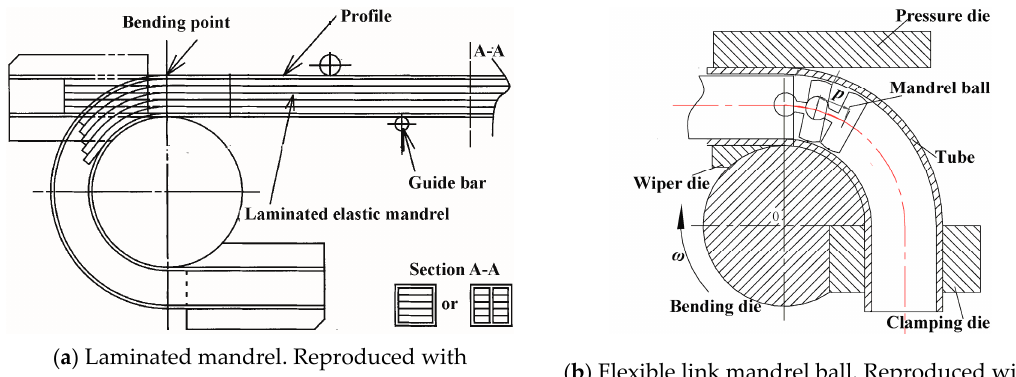
Figure 6. Mandrels used for forming curved profiles [31,32].